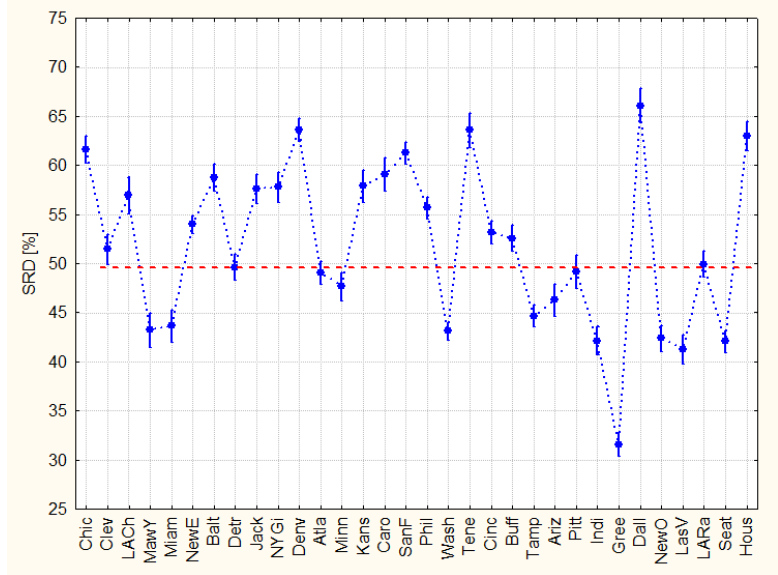
Figure 8. Comparison of teams using sum of ranking differences (scaled between 1 and 100). The points of teams above the dotted red line are indistinguishable from random ranking.